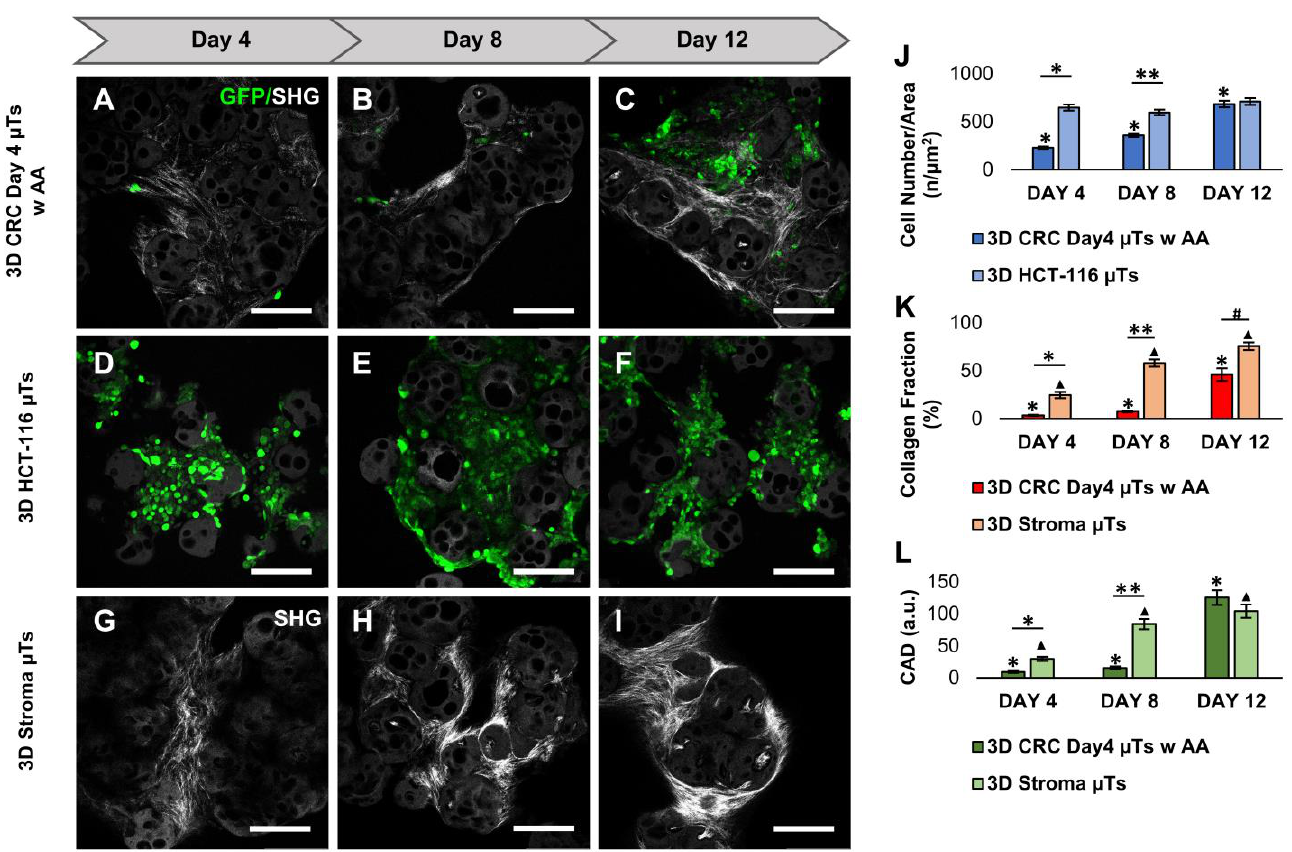
Figure 4. Comparison of cancer cell counts and extracellular matrix (ECM) remodeling between the 3D CRC Day4 µTs with Ascorbic Acid (AA), 3D HCT-116 µTs, and the 3D Stroma µTs, monitored on days 4, 8, and 12 of culturing. ( A – C ) Confocal images of the 3D CRC Day4 µTs with AA. ( D – F ) Confocal images of the 3D HCT-116 µTs. ( G – I ) Confocal images of the 3D Stroma µTs; scale bar: 150 µm; green fluorescent protein (GFP) expressed by HCT-116 cells (green) and collagen Second Harmonic Generation (SHG) signal (gray). ( J ) Graph of cell numbers over time for the HCT-116 cells in the 3D CRC Day4 µTs with AA and the 3D HCT-116 µTs; ( K ) Graph of collagen fraction analysis, and ( I ) collagen assembly degree (CAD) analysis for the 3D CRC Day4 µTs with AA and the 3D Stroma µTs. All the experiments were performed in triplicate (n = 3), and the values represented the mean and the mean standard error ( ∗ ; ∗∗ ; ;# p < 0.05).